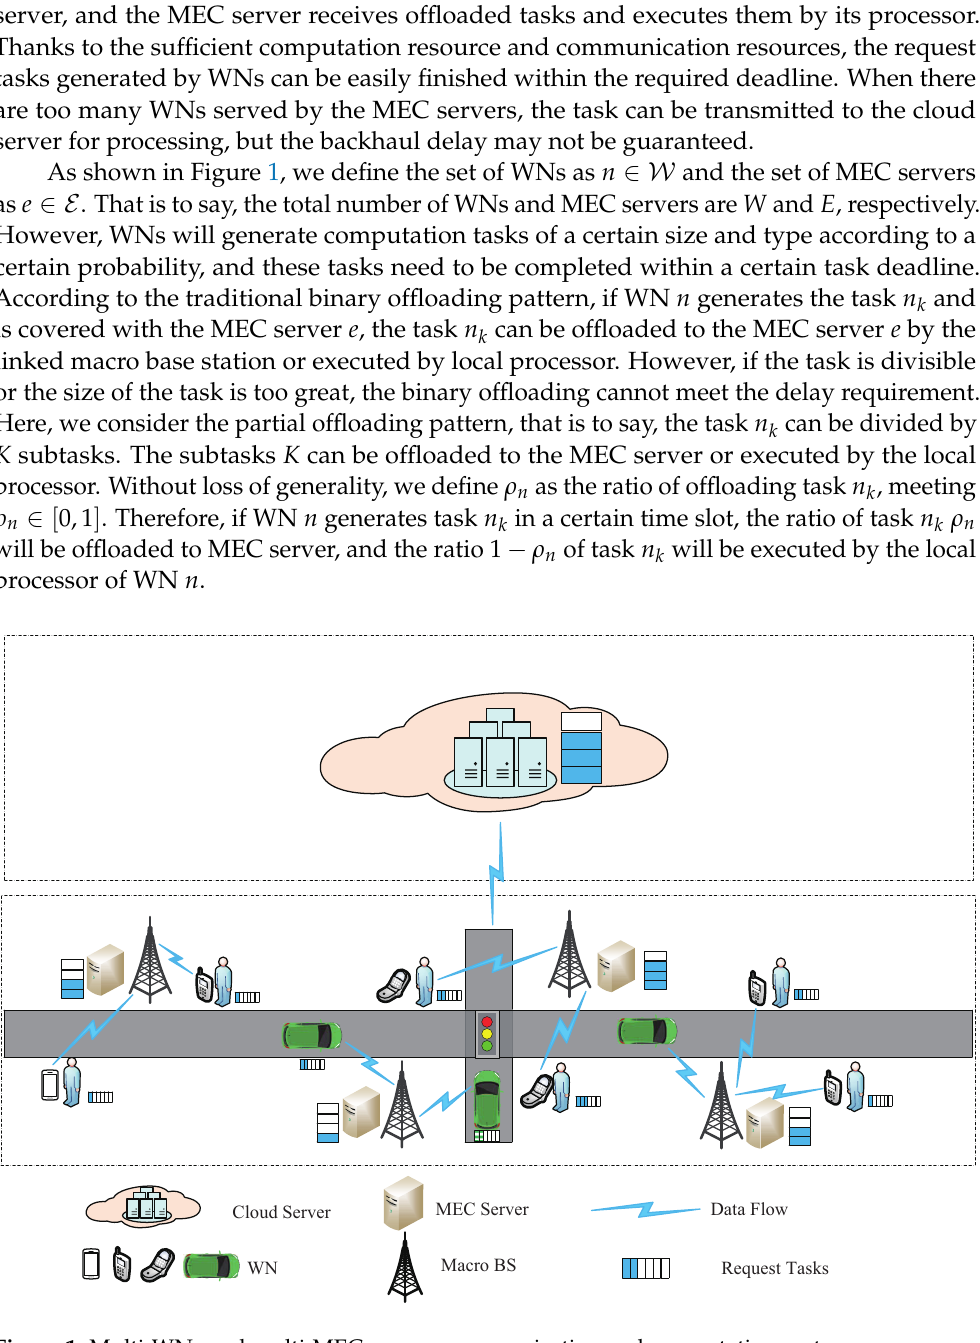
Figure 1. Multi-WNs and multi-MEC servers communication and computation